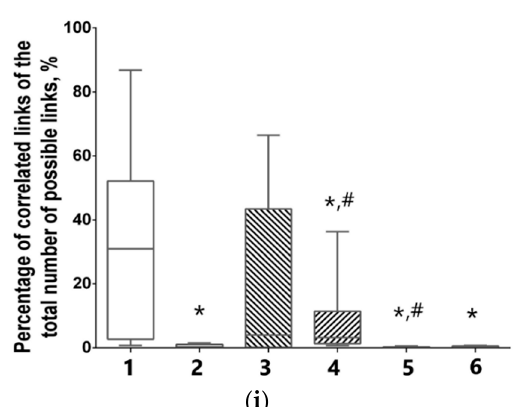
Figure 6. Neuron-glial network activity reorganization in primary hippocampal cultures: 1—Intact; 2—Hypoxia; 3—Hypoxia and neuradapt 1 µ M, immediate treatment; 4—Hypoxia and neuradapt 15 µ M, immediate treatment; 5—Hypoxia and neuradapt 1 µ M, post-treatment; 6—Hypoxia and neuroadapt 15 µ M, post-treatment treatment. ( a – f ) , correlation dependence between spontaneous Ca 2 + oscillations and cell distance: ( a ) Intact; ( b ) Hypoxia; ( c ) Hypoxia and neuradapt 1 µ M, immediate